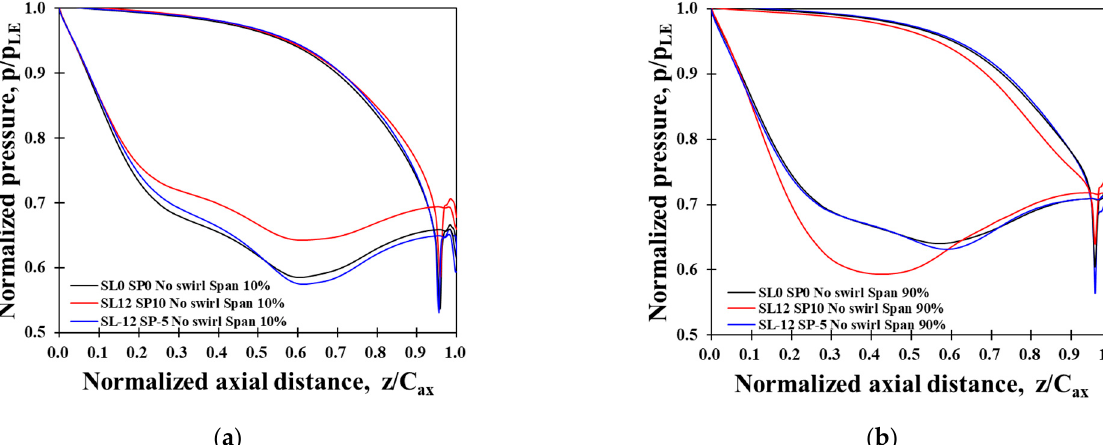
Figure 16. Comparison of NGV loading of the models with maximum efficiency (SL0 SP0 No swirl) and minimum efficiency